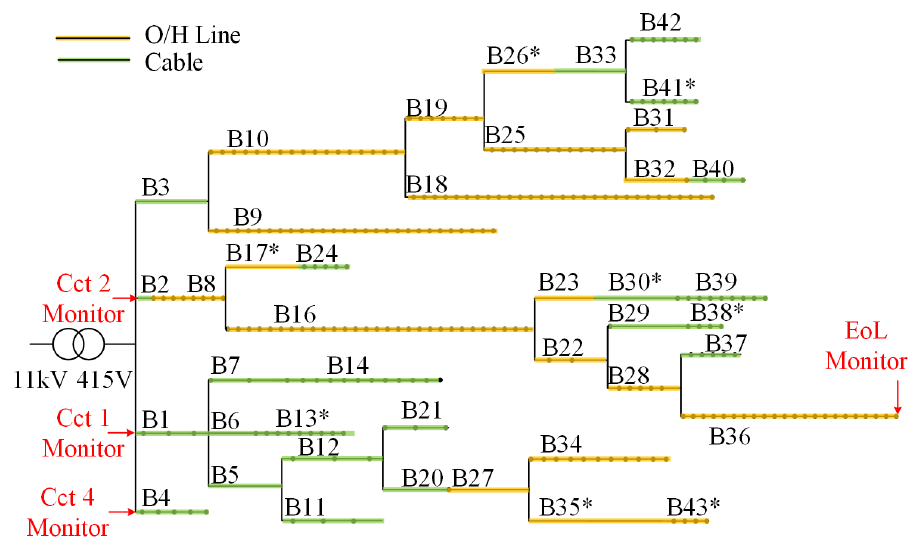
Figure 6. Schematic of network #129 with 265 connections, 10 of which are commercial. Connections are represented as dots and LV monitoring points are indicated in red. * Branch of unknown